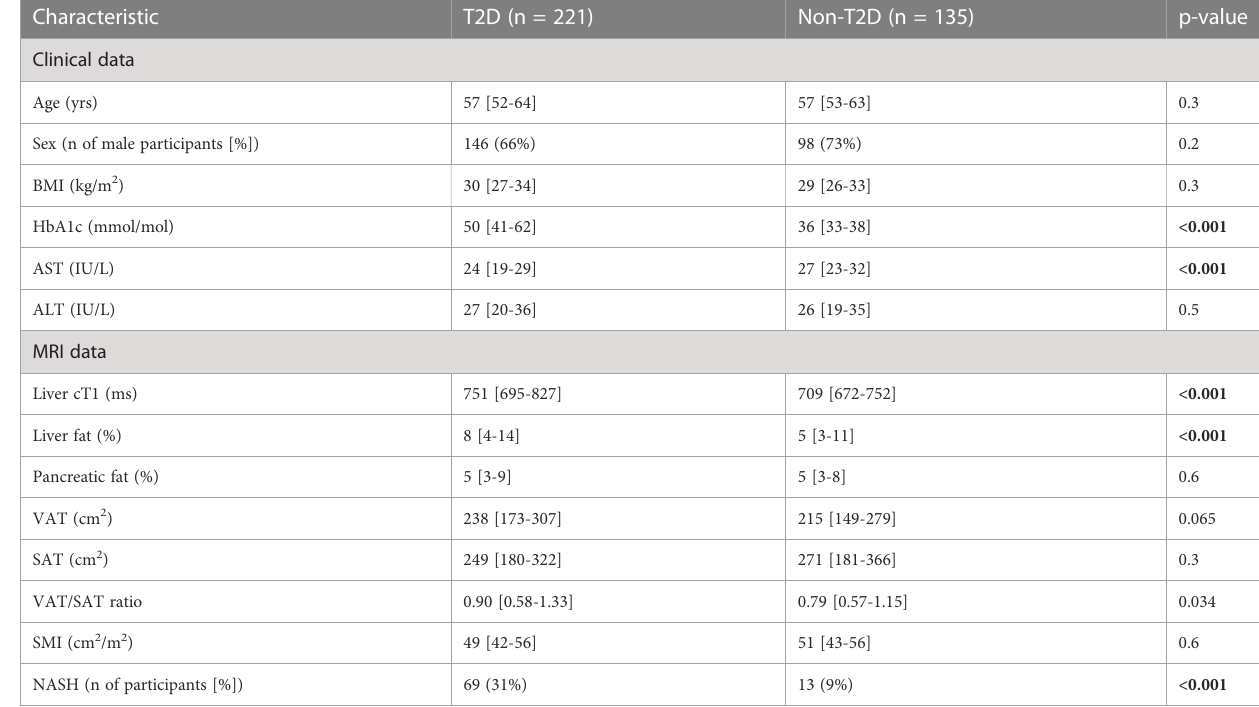
TABLE 1 Baseline characteristics of T2D and non-T2D cohorts.